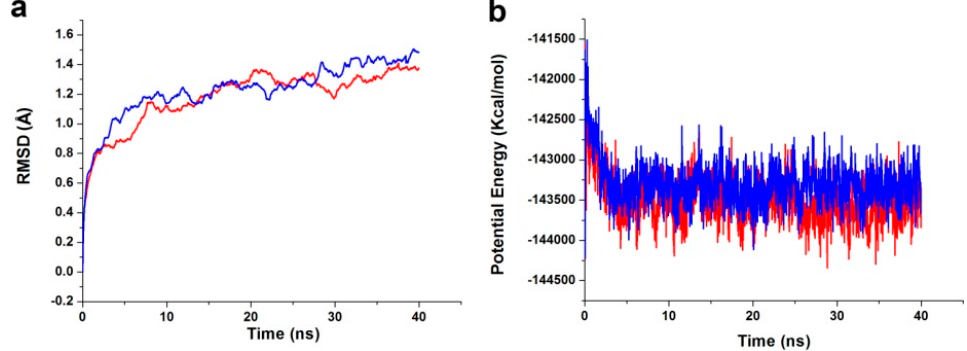
Figure 5. Results of MD simulation of two complexes. ( a ) Average backbone RMSD; ( b ) Potential Energy. Red, ZINC12296427-PDK1; blue, ZINC12389251-PDK1.